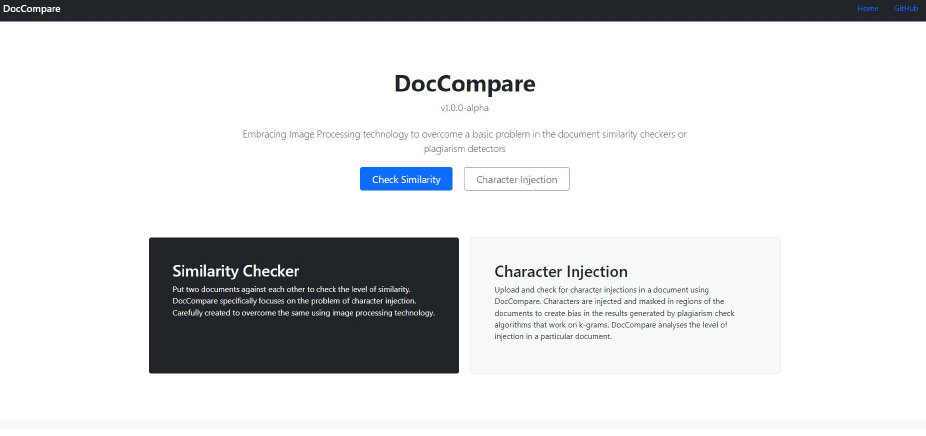
Figure 14. DocCompare-Application Home